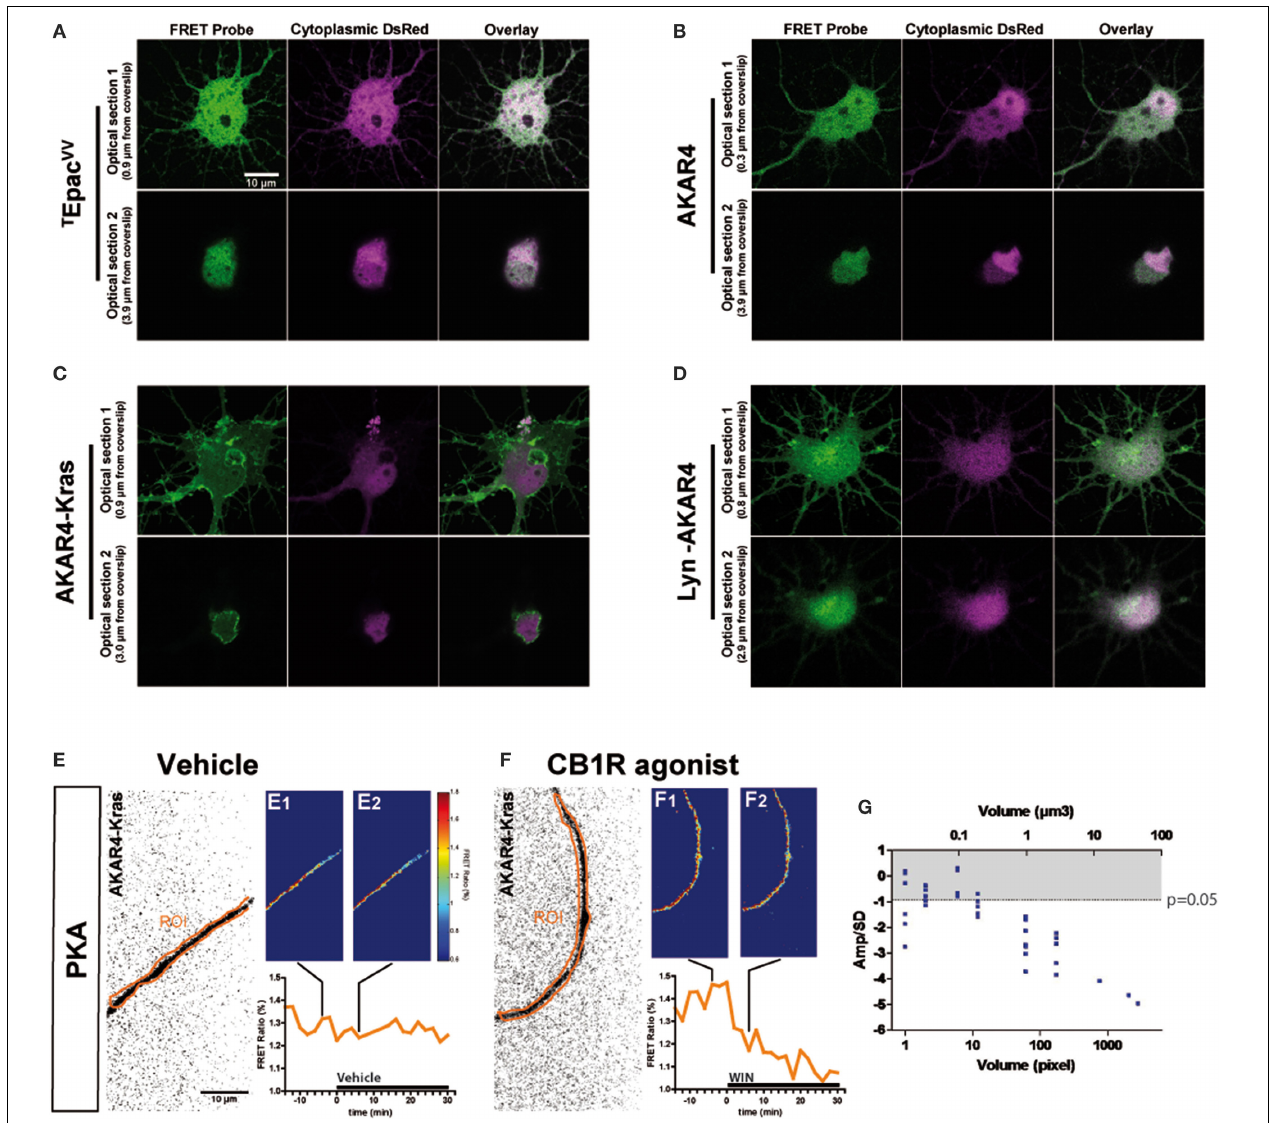
FIGURE 1 | Quantitative measure of basal cAMP/PKA pathway modulation downstream of endogenous neuronal CB1Rs in small cytoplasmic volumes. (A–D) Cultured hippocampal neurons expressing soluble (cytoplasmic) DsRed2 and various FRET probes designed to measure cAMP concentration or PKA activity: T Epac VV (A) , AKAR4 (B) , AKAR4-Kras (C) , LYN-AKAR4 (D) . After fixation, confocal imaging at two different optical sections shows sub-cellular localization of the probes. AKAR4-Kras probes are well-localized to the plasma membrane in the somatodendritic region. (E,F) Modulation of basal PKA activity downstream of endogenous CB1Rs in axonal RegionsofInterest(ROI)inAKAR4-Krasexpressingneurons.Thefirstimageof the acquisition on YFP channel, inverted and with enhanced contrast for better visibility,isshownwiththeROI(orange) (E,F) .ThemeanFRETratioisshownat 4min(-t4)before (E 1 ,F 1 ) andat6min(t6)after (E 2 ,F 2 ) theadditionoftreatment at t0. Incubation with vehicle does not change the FRET ratio (E 2 ) compared to